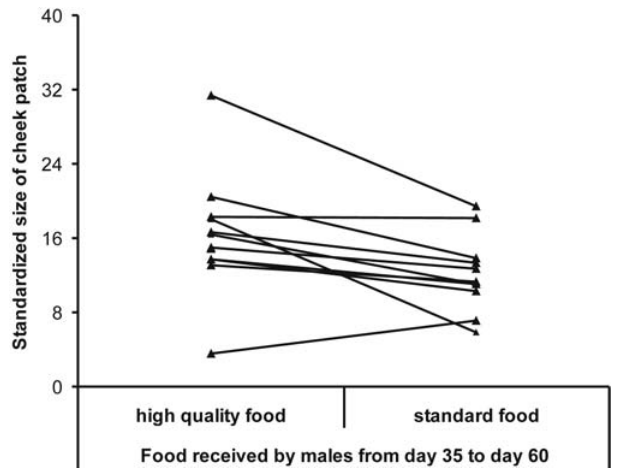
Figure 2. Differences in size of the orange cheek patch at day 60 of paired males as used in mate choice tests at 6 month of age.